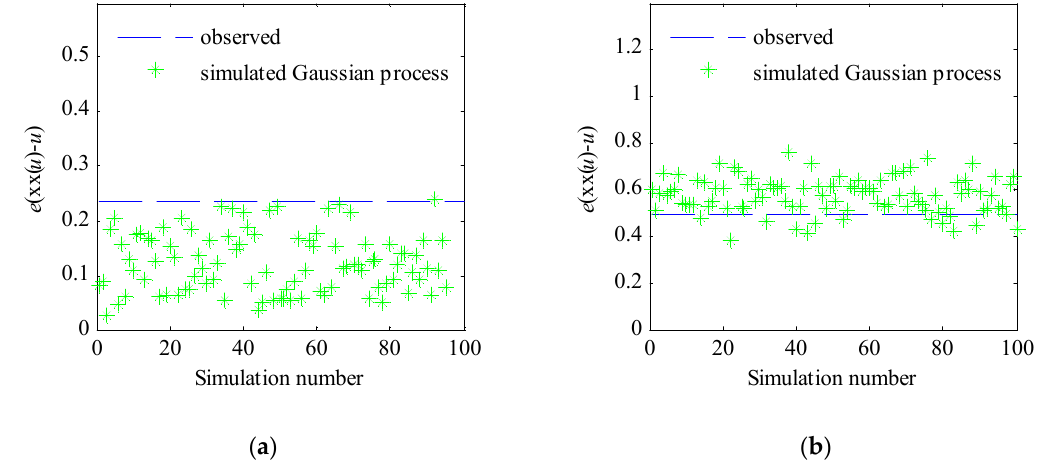
= 1.0583 m and ( b ) H = 0.6069 s